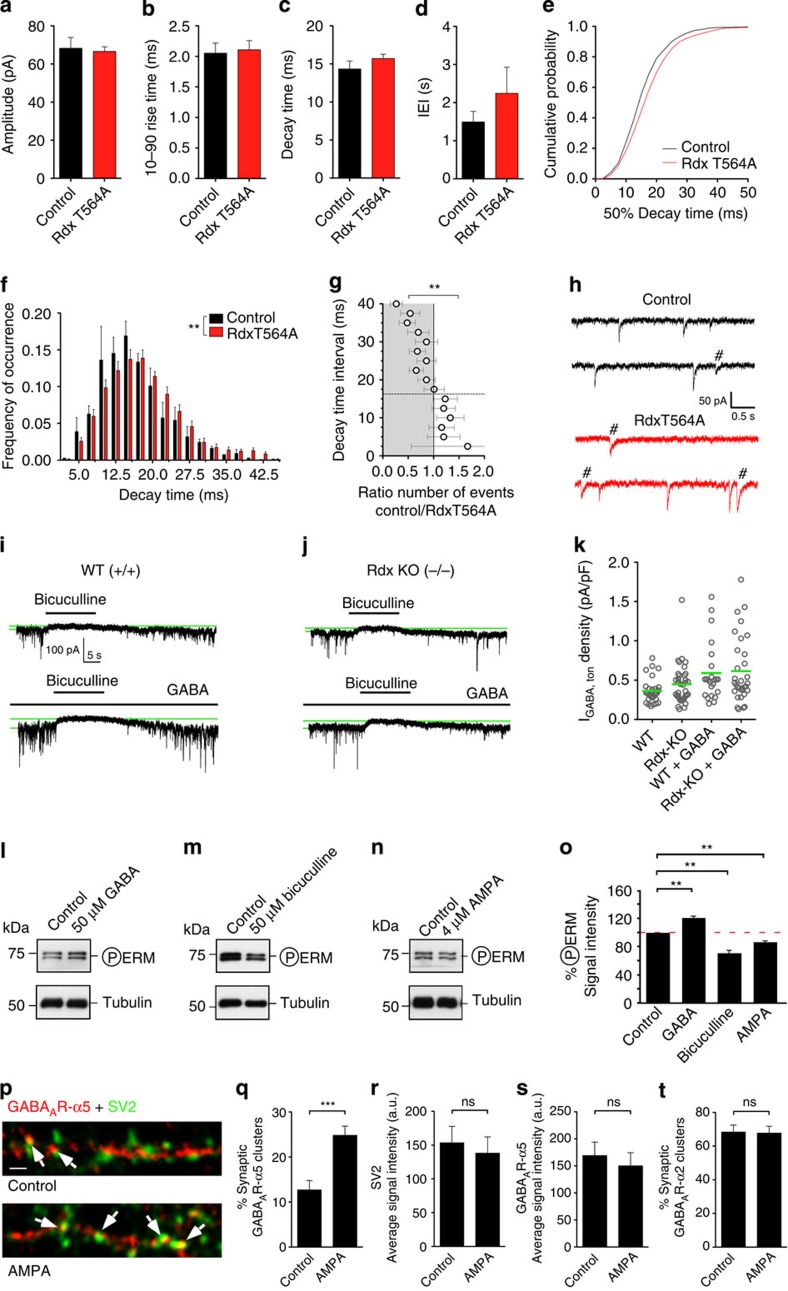
Rdx dephosphorylation depends on neuronal activity changes and increases the occurrence of slowly decaying mIPSCs.(a–h) Impact of RdxT564A or control vector expression on mIPSCs in hippocampal neurons. Mean±s.e.m. of (a) mIPSC amplitudes, (b) 10–90 rise times, (c) 50% decay times and (d) inter-event intervals (IEI) for RdxT564A versus control (P=NS, t-test). (e) Cumulative probability curves of mIPSC decay times for RdxT564A versus control. (f) Frequency distribution histogram of the data shown in e (**P<0.01; negative binominal regression; n=3; 12–13 cells per experiment). (g) Forrest plot of the data shown in f, representing ratios of the number of events for the decay times indicated. (h) Representative traces of GABAergic mIPSCs. ‘#' indicates slow events, typical for GABAAR-α5-mediated mIPSCs. (i–k) Tonic GABAergic currents in hippocampal neurons derived from (i) Rdx-WT (+/+) or (j) Rdx-KO (−/−) in the presence of 10 μM DNQX, 50 μM AP-5 and 500 nM tetrodotoxin. Currents were measured in the absence (upper panels) or presence of 100 nM GABA (lower panels). Application of 100 μM bicuculline blocked GABA currents. The amplitude of the bicuculline-sensitive tonic currents (distance between green lines in each panel) was converted into current density and plotted in a (k) dot plot (mean±s.e.m (pA per pF) for WT: 0.36±0.03, Rdx-KO: 0.45±0.05, P=0.12, n=28–35; WT+GABA: 0.59±0.08, Rdx-KO+GABA: 0.61±0.07, P=0.8, n=22–29, Mann–Whitney U-test). (l–s) Neuronal activity-dependent Rdx phosphorylation and synaptic re-distribution of GABAAR-α5. (l–n) Representative western blots detecting the phosphorylation of ERM proteins in hippocampal neurons on treatment with (l) 50 μM GABA, (m) 50 μM bicuculline or (n) 4 μM AMPA. (o) Quantification of ERM phosphorylation levels shown in l–n (control: set to 100%, GABA: 121.00±2.48%, bicuculline: 73.44±4.47%, AMPA: 86.00±1.15%; n=3–8; ANOVA and one-sample t-test against 100%). (p) Synaptic localization of GABAAR-α5 in neuronal dendrites (arrows) on excitatory synaptic potentiation (4 μM AMPA, 1 h). (q) % Synaptic GABAAR-α5 (control: 12.72±2.07%, AMPA: 24.82±2.04%). (r) SV2 signal intensities (control: 153.36±24.36 a.u., AMPA: 138.18±23.98 a.u.). (s) GABAAR-α5 signal intensities (control: 169.26±24.68 a.u., AMPA: 150.14±24.30 a.u.). (t) % Synaptic GABAAR-α2 remained unchanged (control: 68.39±4.12%, AMPA: 67.72±4.12%; n=3; 10–11 cells per experiment; ANOVA). Error bars, mean±s.e.m.; **P<0.01, ***P<0.001. NS, not significant.